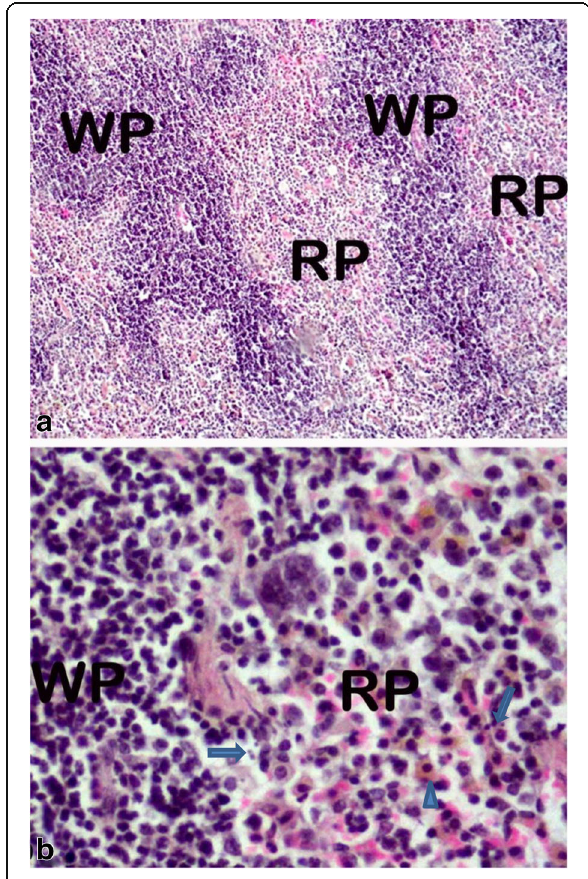
Fig. 5 Histological sections of spleen from the mice in G12 treated with TME of C. swynnertonii (TME, 1500 mg/kg), 8 hourly intervals for three days consecutively. In ( a ), the white and red pulps are markedly reduced in size; the PALS has normal cellularity, lymphoid follicles and marginal zone are depleted. There is moderate apoptosis with karyorrhexis ( arrows ) and pyknosis of lymphocytes in ( b ). Magnifications, ( a ) 100 x; ( b ) 400